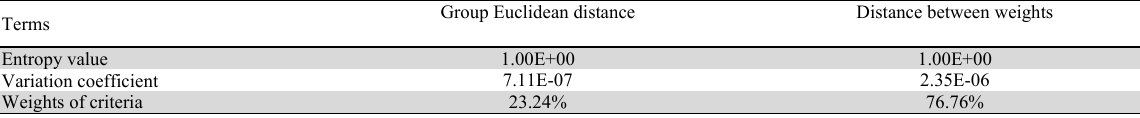
Weights of the evaluation metrics using Shannon entropy method Terms